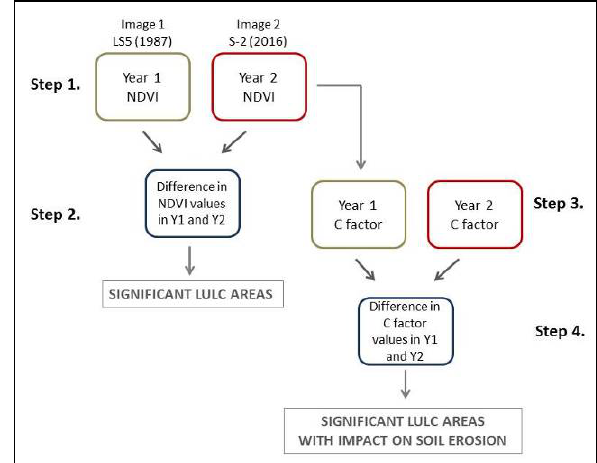
Figure 5. Methodology proposed for estimation of significant land change areas with possible impact on soil erosion